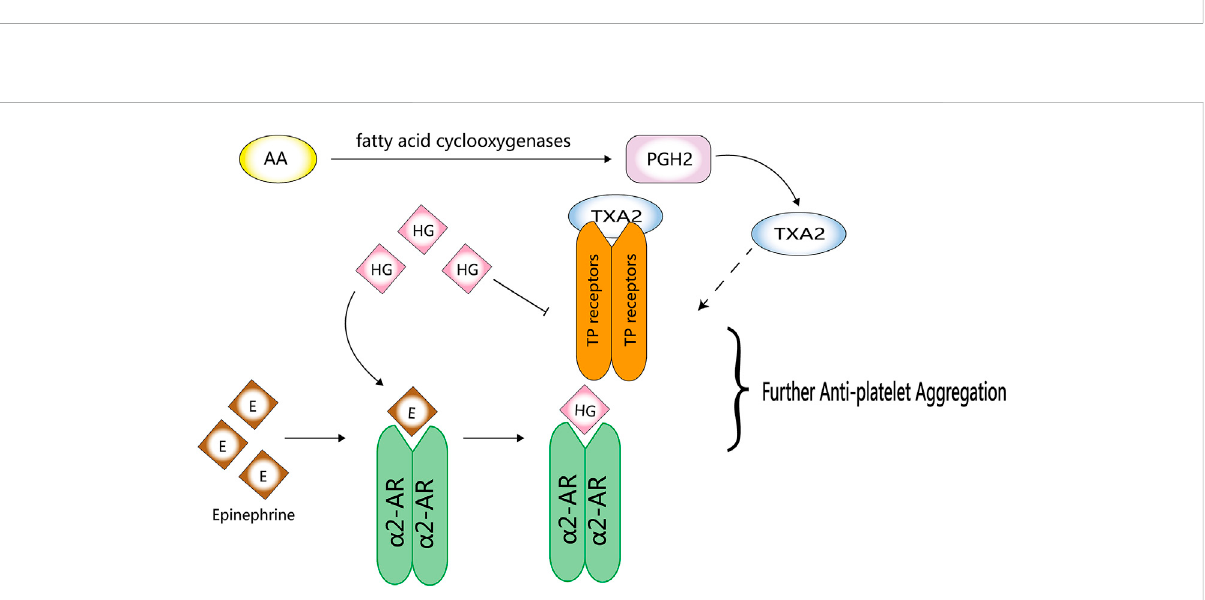
FIGURE 4 Anti-platelet activity of HG. HG can competitively inhibit the binding of epinephrine to α 2-AR and directly act on TP receptors to inhibit platelet aggregation.